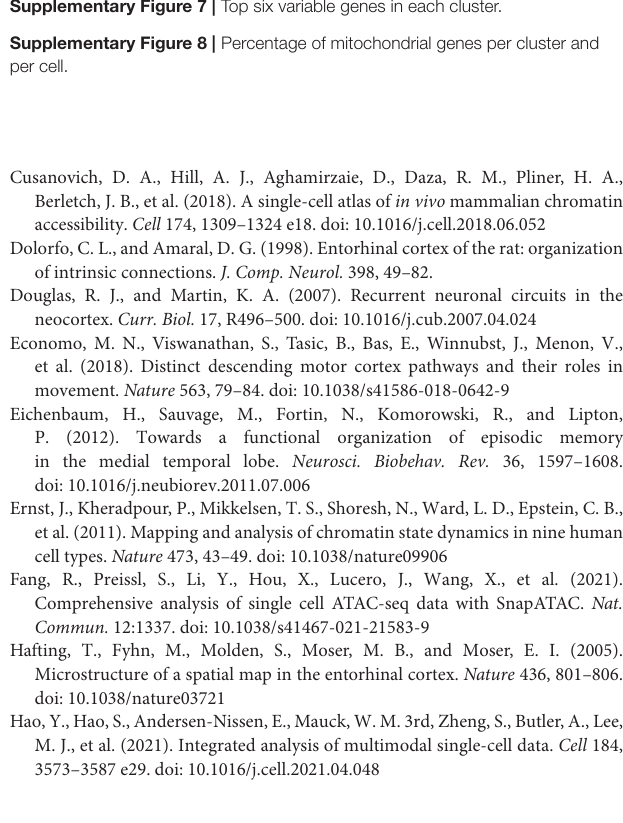
Supplementary Figure 1 | Selection of legitimate nuclei. (A–D) Projection of all cells before filtering. Cells within the bounding boxes (promoter ratio 0.05–0.30, UMI 4–5.5) were selected for further analysis. Supplementary Figure 2 | Clustering metrics and quality control metrics. (A) Projection of single cells on eigen vector axis. Each panel uses two eigen vectors. The top 20 eigen vectors were selected as input for the KNN graph and community detection. (B) Clusters and cluster numbers for reference. (C) Cells labeled with the fraction of reads in peaks. (D) Cells labeled with the fraction of duplicate reads. (E) Cells labeled with the read depth. (F) Numbers of cells for each cluster and each sample. Supplementary Figure 3 | Identification of cell classes. (A) Identification of different cell classes and types by the accessibility of particular genes. In the case of (A) the gene is C1qc, which shows a high gene accessibility score in cluster 6, identifying this cluster as microglia. This is repeated for all major cell classes. (B) Hapln2; oligodendrocytes. (C) Flt1; endothelial cells. (D) Lcat; astrocytes. (E) Ccdc153; potentially ependymal cells. (F) Dynlrb2; potentially ependymal cells. (G) Snap25; neuronal cells. (H) Pnoc; inhibitory neurons. (I) Slc17a7a; excitatory neurons. (J) Motifs found in inhibitory and excitatory cell types. Here contrasts were set between DARs for all inhibitory cells (clusters 4, 5, 13, 20) and all excitatory cells (clusters 1, 2, 3, 7, 8, 10, 14, 15, 16, 17, 19). Supplementary Figure 4 | Relative accessibility of DARs. The scale bar represents the mean Z-score of all DARs per cluster. Supplementary Figure 5 | Clustering and quality control metrics for the transcriptomic data. Supplementary Figure 6 | Top variable genes in the 50 principle components. The green box indicates PC44. Supplementary Figure 7 | Top six variable genes in each cluster. Supplementary Figure 8 | Percentage of mitochondrial genes per cluster and per